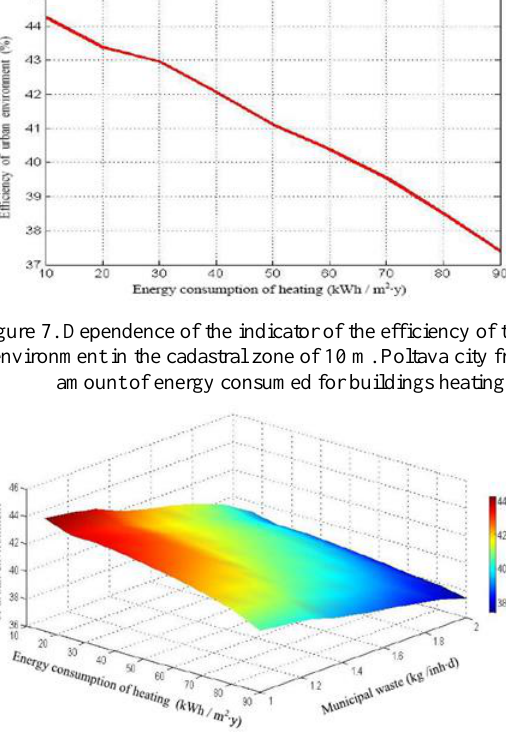
Figure 8. The surface of the efficiency of the urban environment in the cadastral zone of 10 m in Poltava city, depending on the amount of energy consumed for the heating of buildings and produced solid household waste Figure 4. Geoinformation modelling the state of the urban